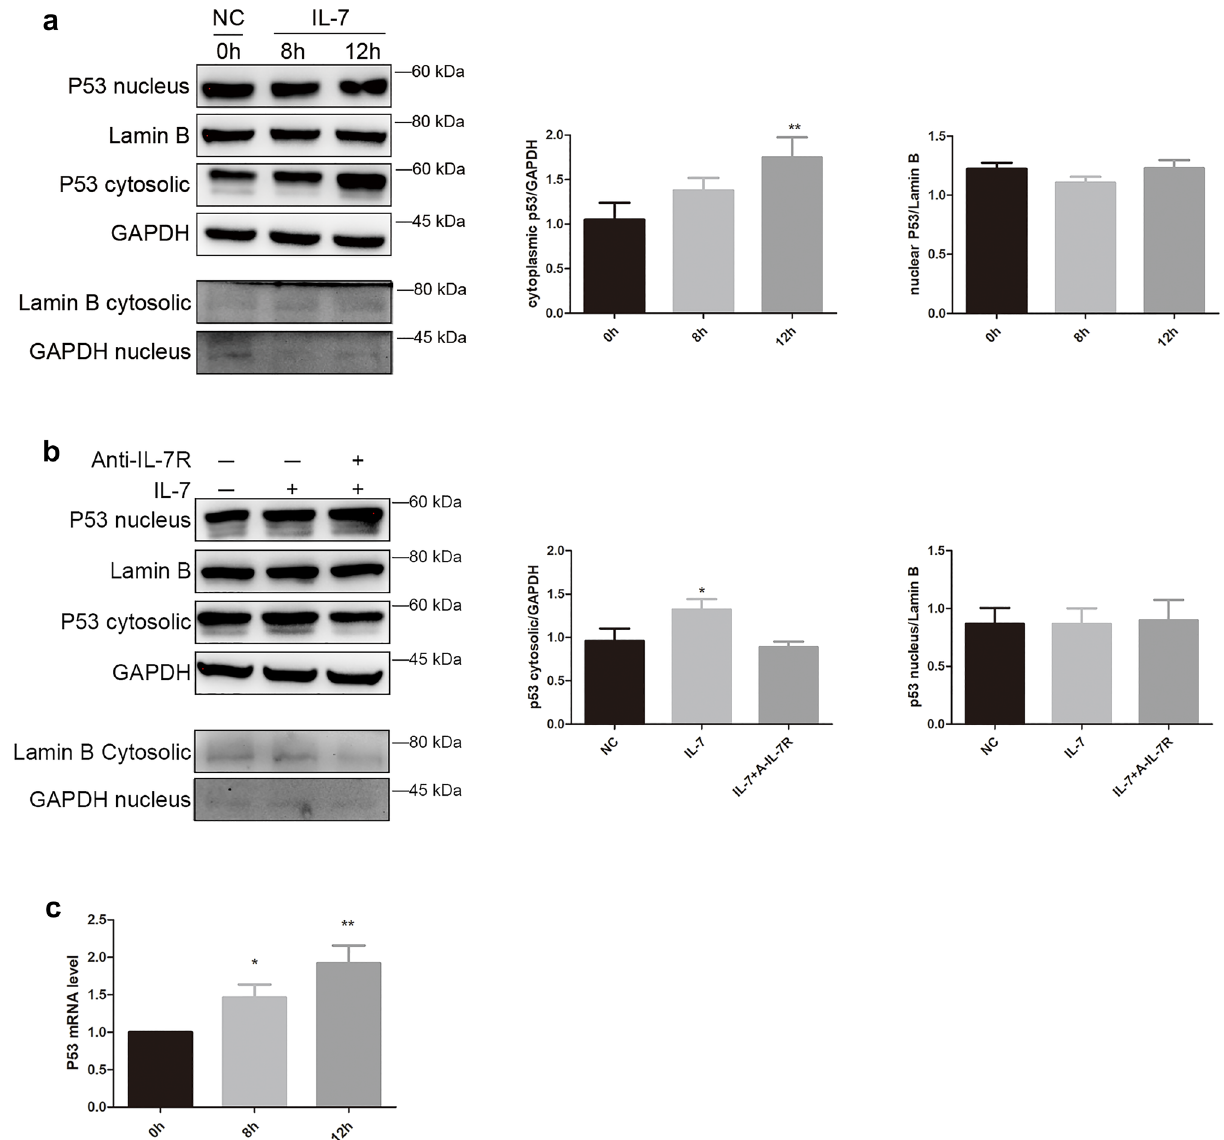
Figure 1. Isolation of cytoplasmic and nuclear p53 protein for A549 cells after treated with interleukin 7 (IL- 7), anti-IL-7 receptor antibody (A-IL-7R) for western blot analysis. Then total RNA was isolated for real-time quantitative PCR (RT-qPCR) assay after incubated with IL-7 for different time. ( a ) A549 cells were treated with IL-7 at 24 ng/ml for 8 h and 12 h, then p53 nuclear and cytoplasmic protein were detected. Lamin B was used as nuclear loading control and GAPDH was used for cytoplasmic loading control. Cytoplasmic Lamin B and nuclear GAPDH were detected to validate nuclear protein was not contaminated by cytoplasmic protein and cytoplasmic protein were not contaminated by nuclear protein. Bar show the cytoplasmic and nuclear p53 western blot analysis. ( b ) A549 cells were treated with IL-7 and A-IL-7R plus IL-7 for 12 h, then nuclear and cytoplasmic p53 protein were detected by western blot. Cytosolic Lamin B and nucleus GAPDH was detected as negative control. Bar show the cytoplasmic and nuclear p53 western blot analysis. ( c ) After incubated with IL-7 at different time (0 h, 8 h, 12 h), p53 mRNA level was detected by RT-qPCR, all the bar graph expressed as Mean ± SD, n = 3. *represent for P < 0.05 versus negative control (NC). **represent for P < 0.01 versus